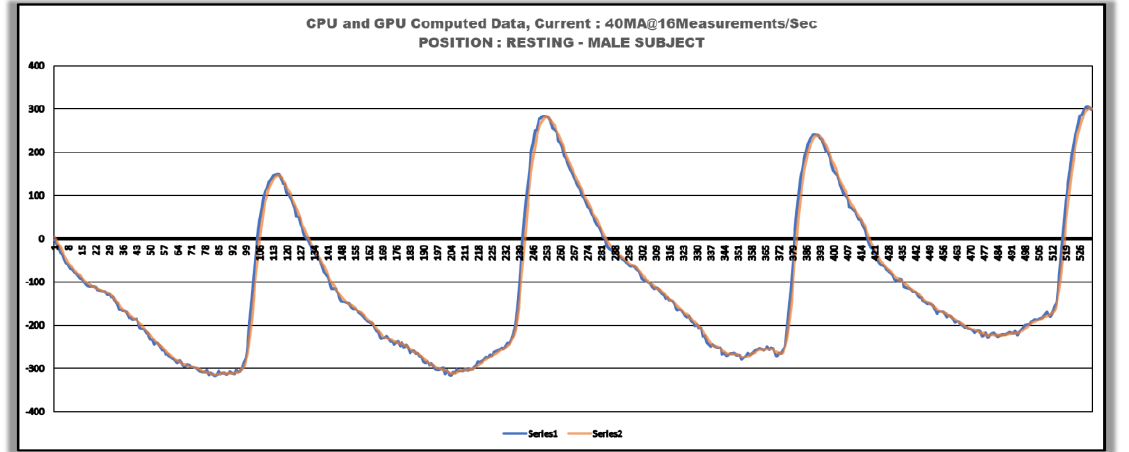
Figure 16. GPU- and CPU-computed signals using